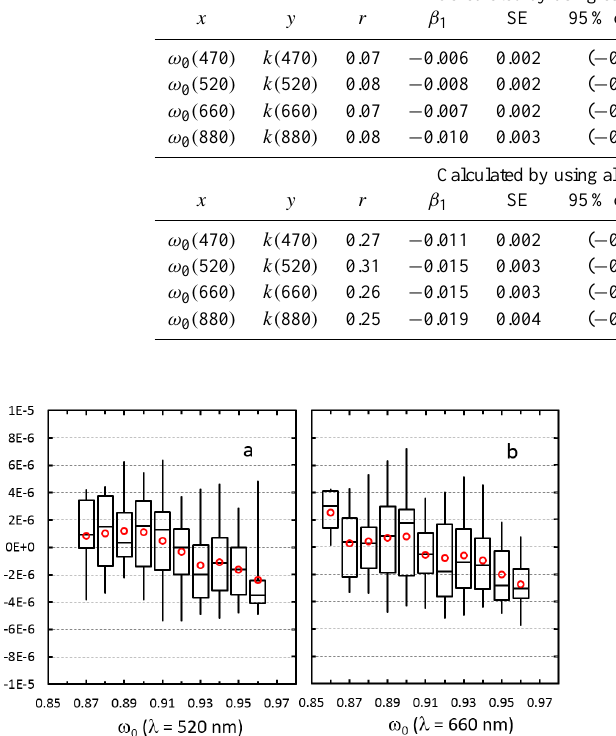
Figure 9. Daily averaged slope ( a k ) of the compensation parameter classified into 0.01 wide bins of the single-scattering albedo ( ω 0 ) at (a) green ( λ = 520nm) and (b) red ( λ = 660nm) wavelengths. The box plots present the 5th, 25th, 50th, 75th, and 95th percentiles and the circles the averages in each